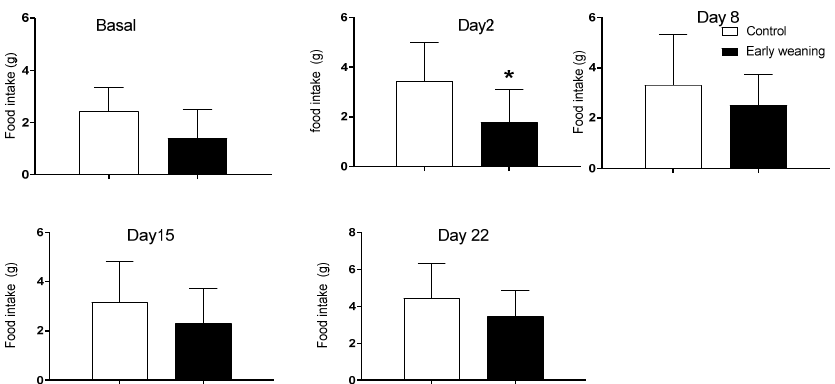
Figure 4. Effect of Early Weaning associated with chronic stress on chocolate cookie (Bauducco) intake. Data were obtained from animals during their 166–168 days of age (basal analysis) and on days 2 (169–171 days of age), 8 (175–177 days of age), 15 (182–184 days of age), and 22 (188–190 days of age) of alimentary stress. t -test n = 8. Data expressed as mean ± SD. * p < 0.05 vs. controls.